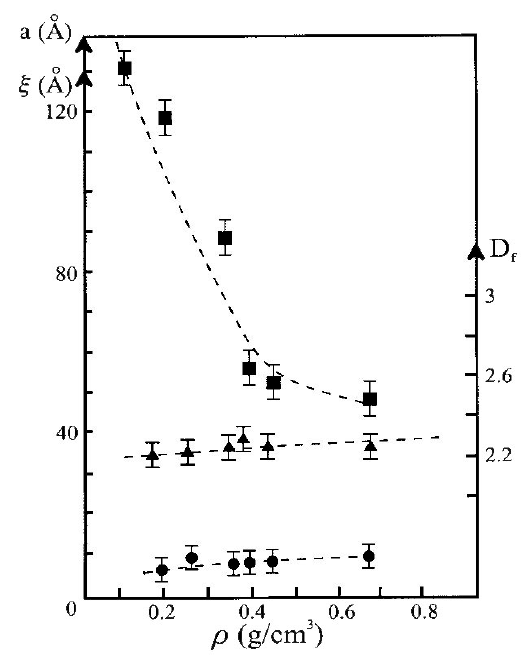
Figure 12. ξ (squares), a (circles) and D f (triangles) evolution versus the bulk density for the N18 compressed aerogels set (from [53]).